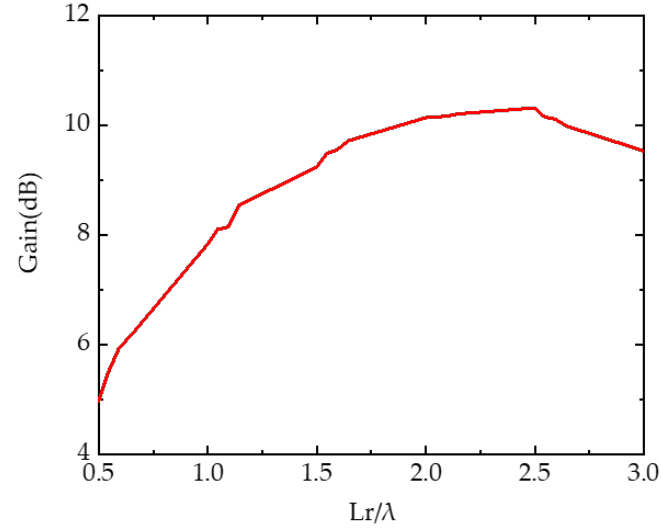
Figure 2. Structure of the low profile surface-wave antenna: ( a ) main view, ( b ) side view.